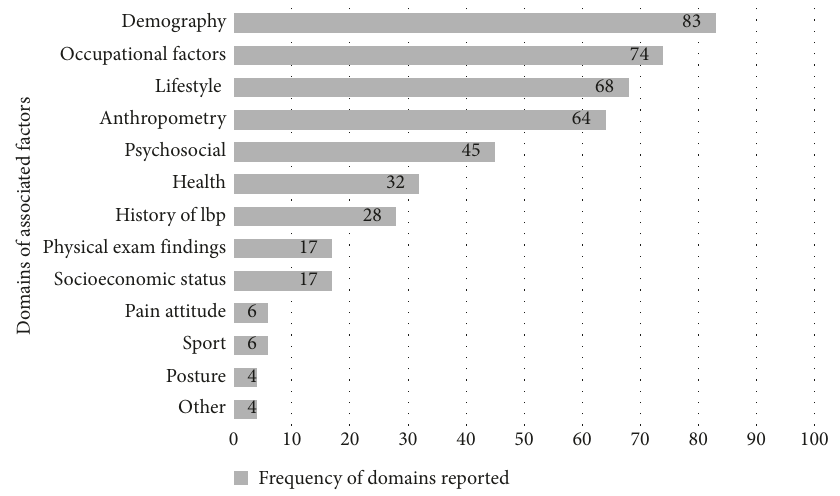
Figure 2: Domains of associated factors investigated in all included studies (regardless of the LBP